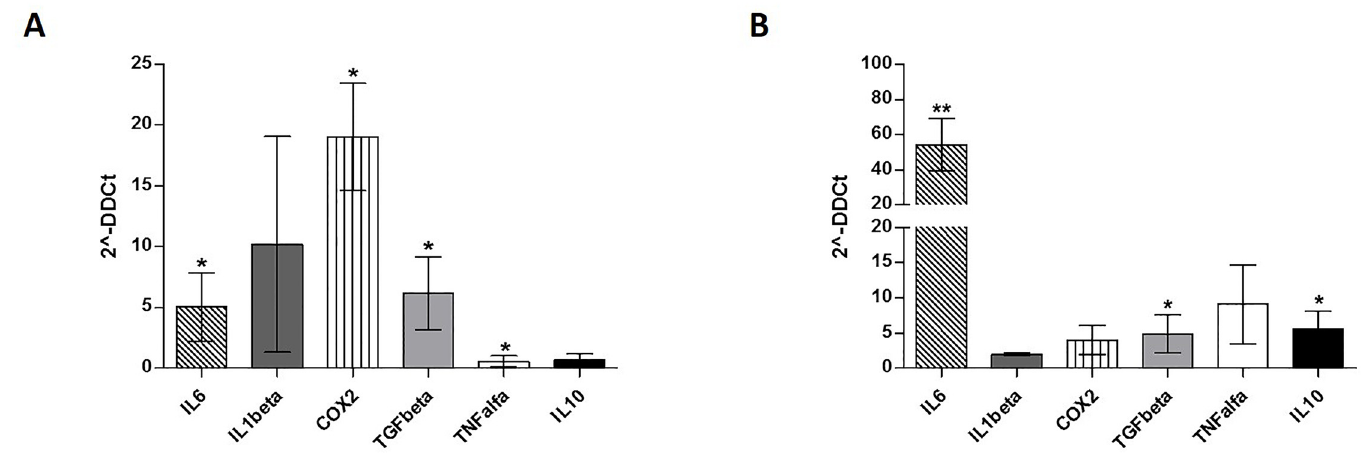
Fig 3. Expression of immunomodulatory factors by CML-MSC. Compared to HD-MSC, CML-MSC showedsignificant up-regulation of IL6, COX2and TGF β at Time 0 ( A ) and overexpressed IL6, TGF β and IL10 after 48 h of co-culture with PBMC ( B ). Calculated value of 2^- ΔΔ Ct in HD-MSC was 1.